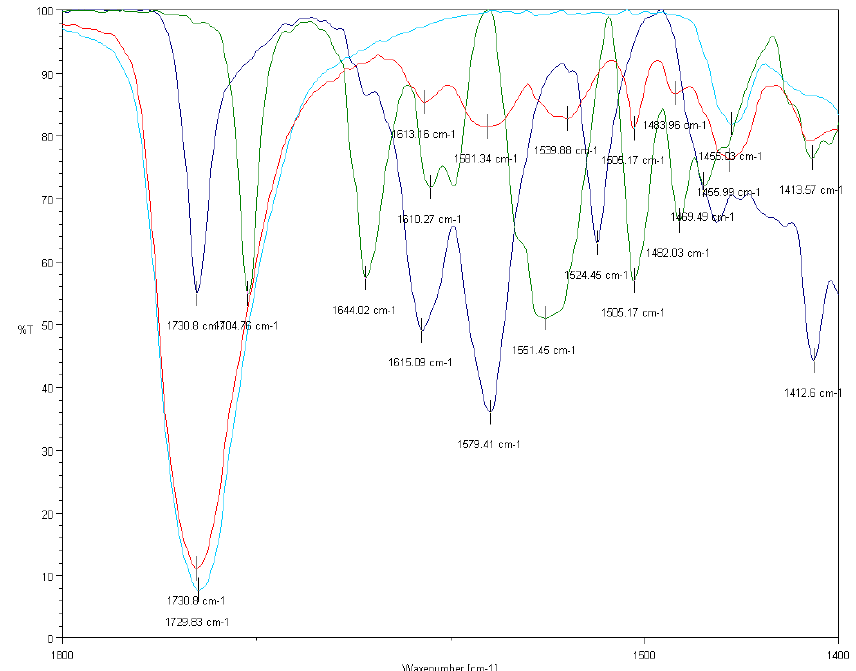
Figure 3. FTIR spectra of doxorubicin HCl salt (dark blue), sorafenib (green), PHB polymer (light blue) and dual drug-loaded PHB nanoparticles (red) in the 1400–1800 cm − 1 wavenumber region.